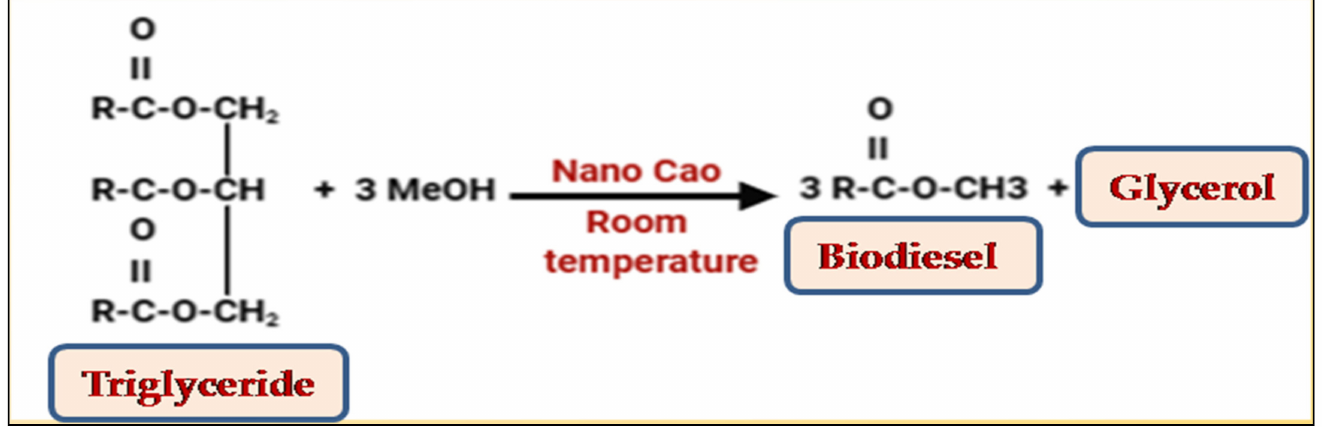
Figure 3. Preparation of FAME (fatty acid methyl ester)Biodiesel from